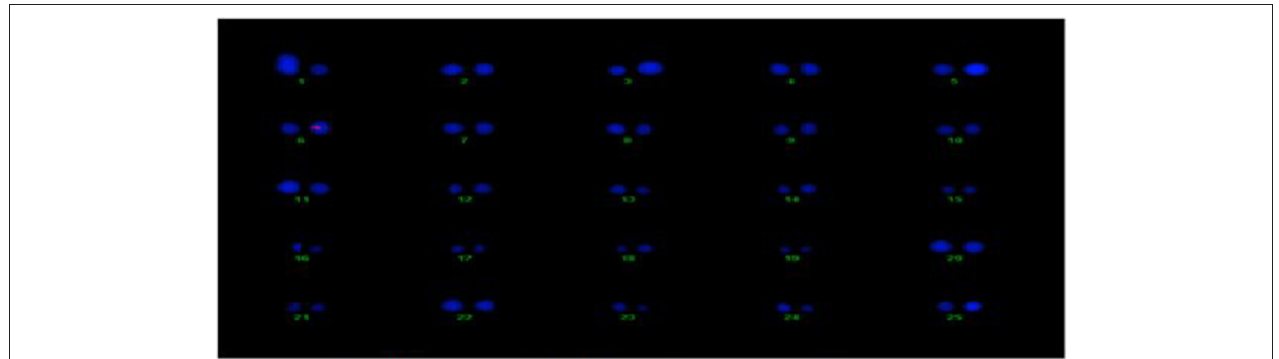
FIGURE 12 | Determination of Cry2A transgenic location on cotton chromosomes.